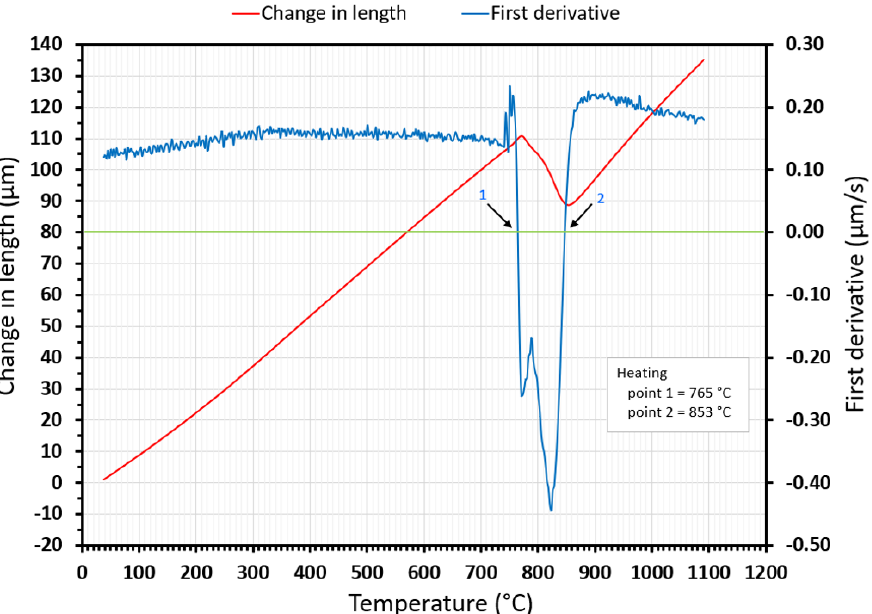
Figure 5. The heating part of the dilatometry curve for a 10 ◦ C/s heating rate with applied first derivative.